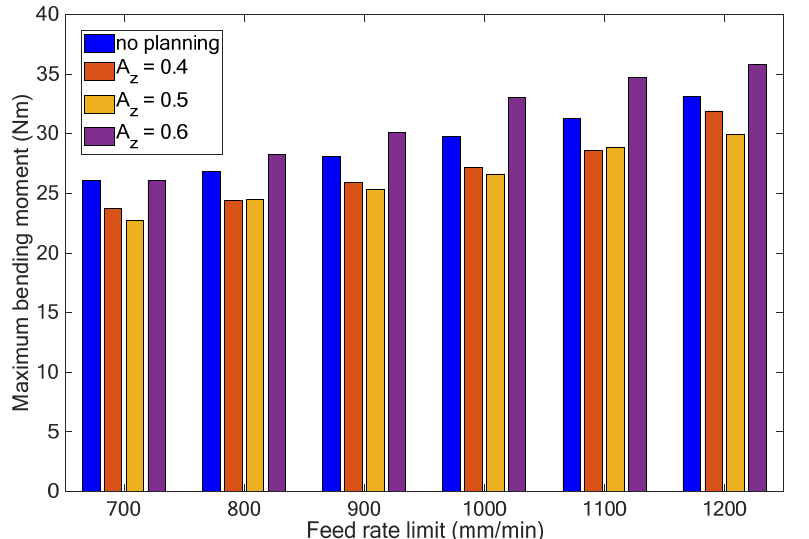
Figure 11. Maximum bending moments with different feed rate limits and adaptive feed rate planning.